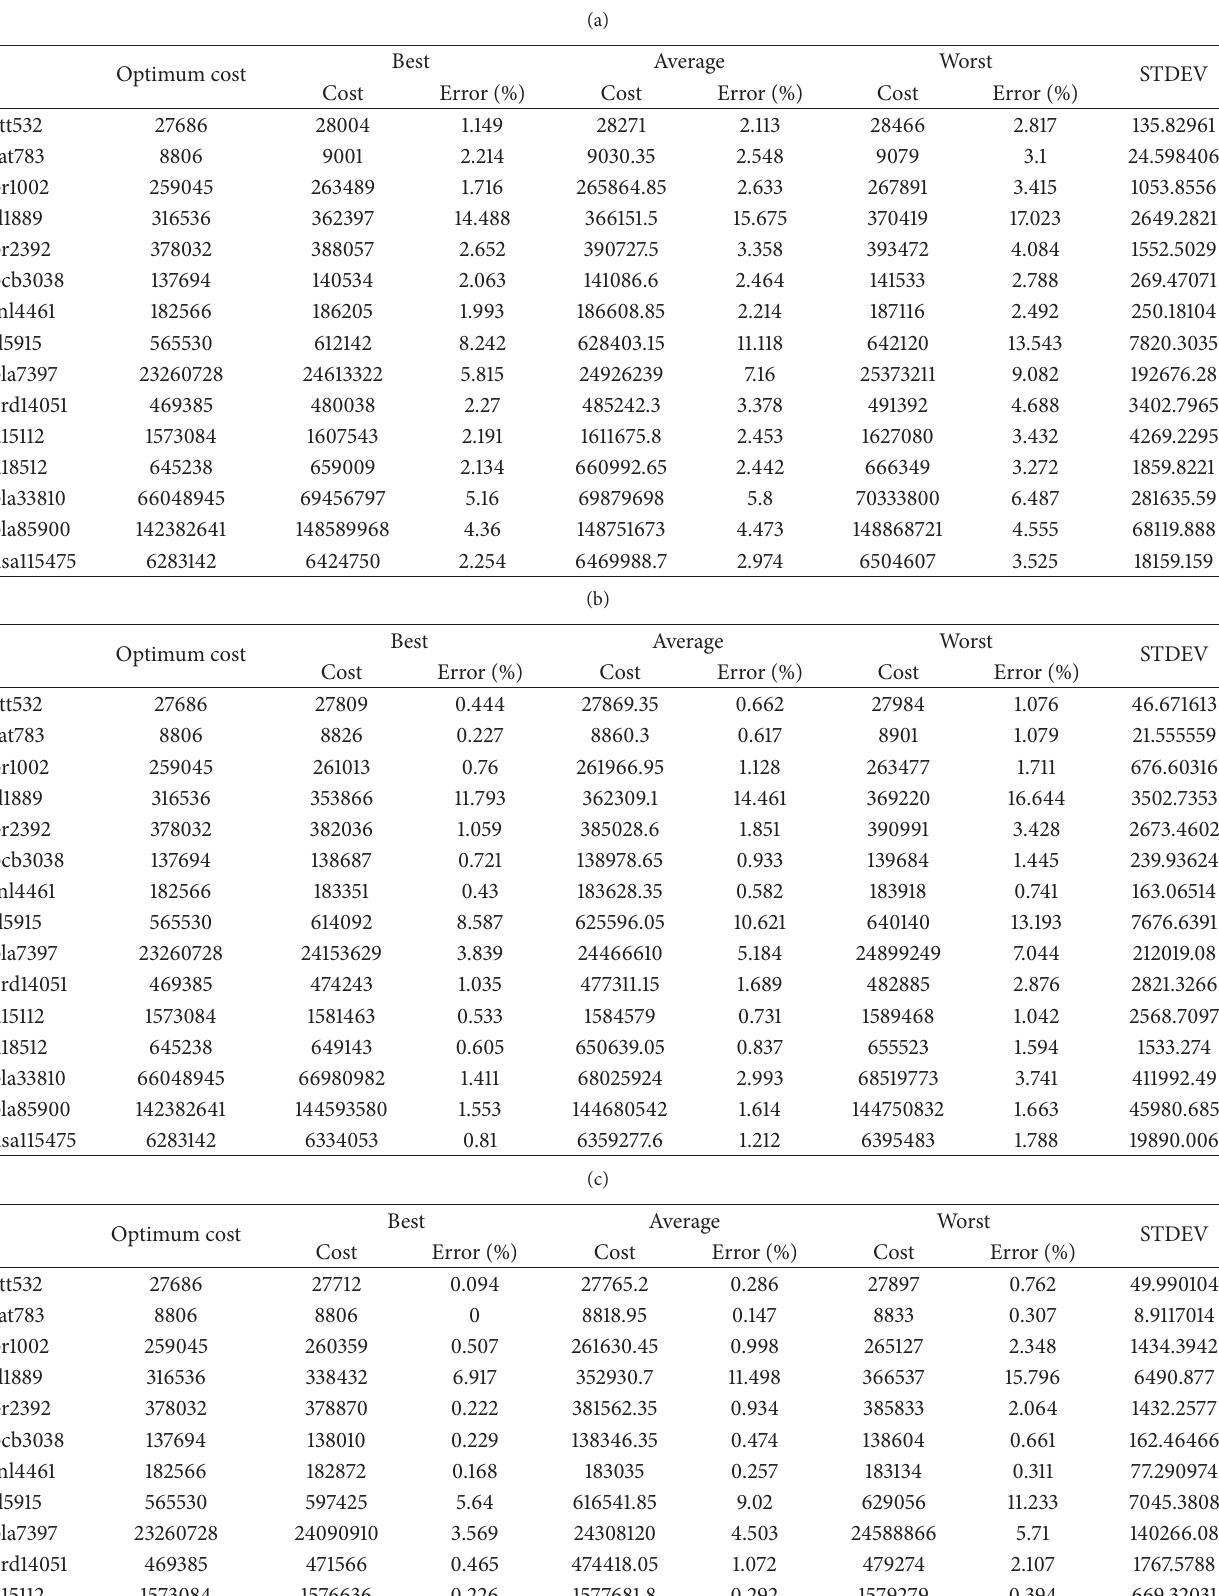
Table2:(a)2-Optperformancebasedonsolutioncosts.(b)3-Optperformancebasedonsolutioncosts.(c)LKperformancebasedonsolution